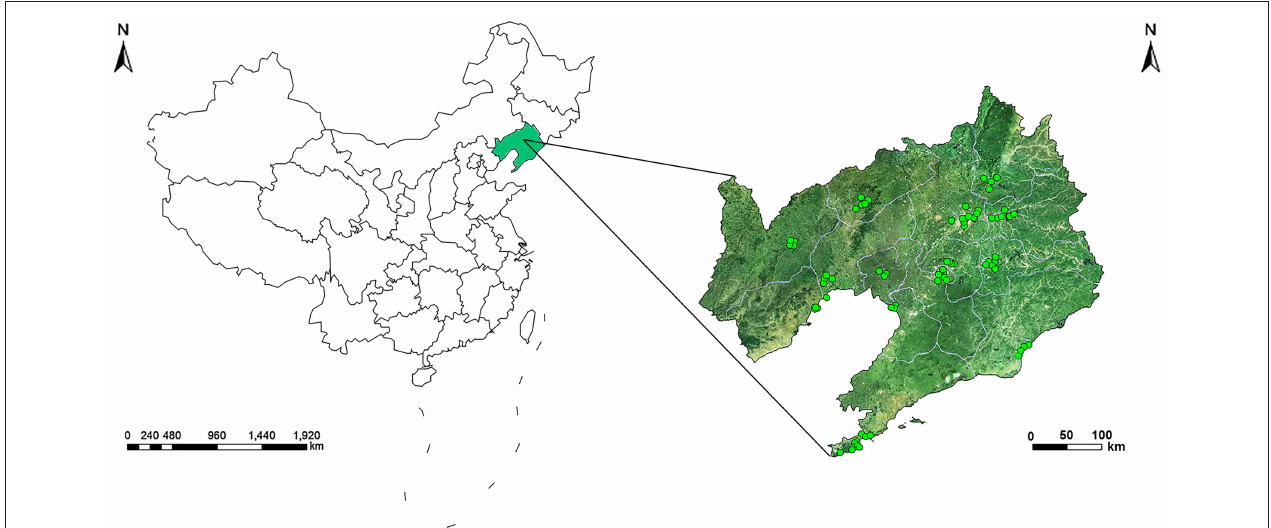
FIGURE 1 | Geographic locations of air monitoring stations in 14 cities in Liaoning Province,